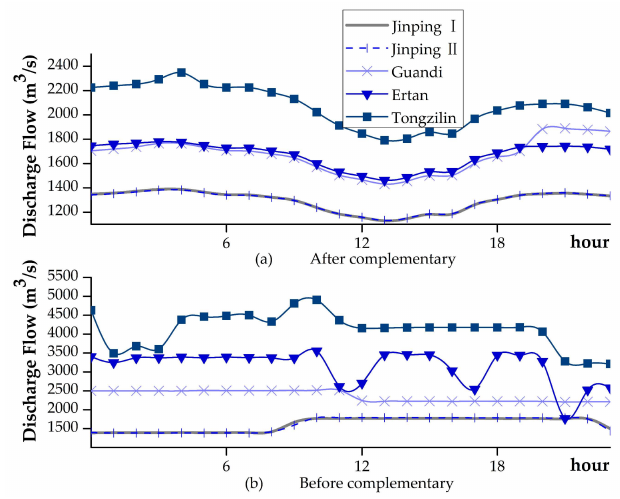
Figure 12. Discharge flow processes of R-A before, and after, complementary